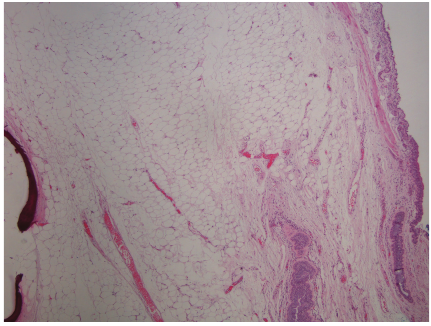
Figure 4: Low power H&E stain of the specimen showing respira- tory epithelium, underlying fat and metaplastic bone.